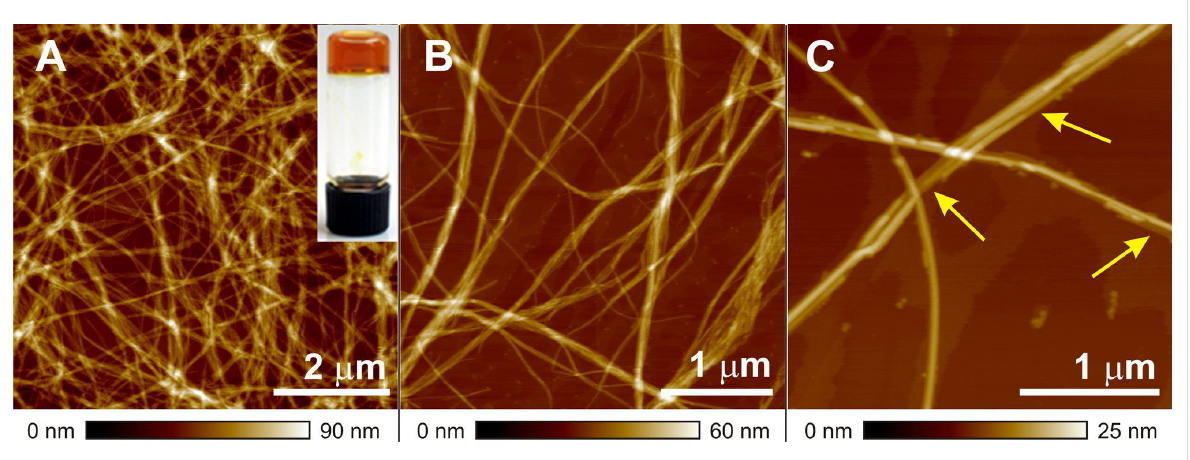
Figure 1: AFM height images of a film spin-coated from diluted gel solution of T1 in MCH (2 × 10 − 3 M) onto HOPG (A, B and C). The z scale (90, 60 and 25 nm, respectively) is shown under the respective image. Inset in 1A: a photograph of gel in cyclohexane at 1.5 mM concentration.